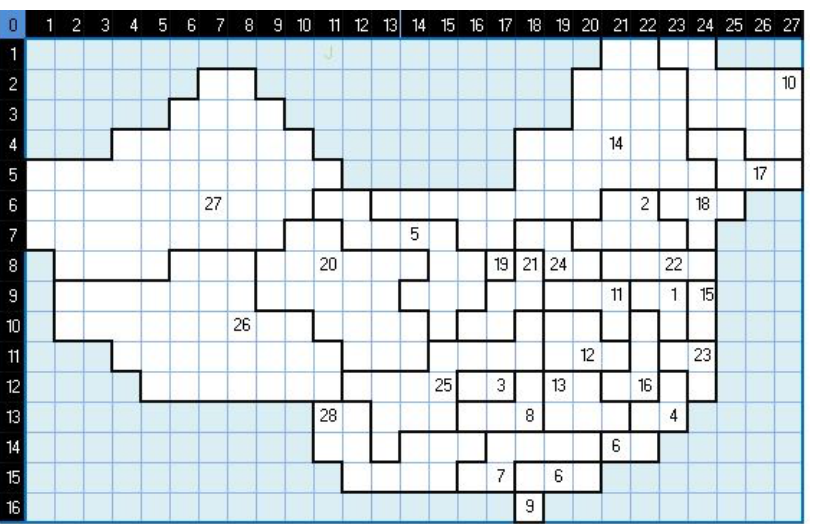
Figure 6. The coordinate cells of China in cellular